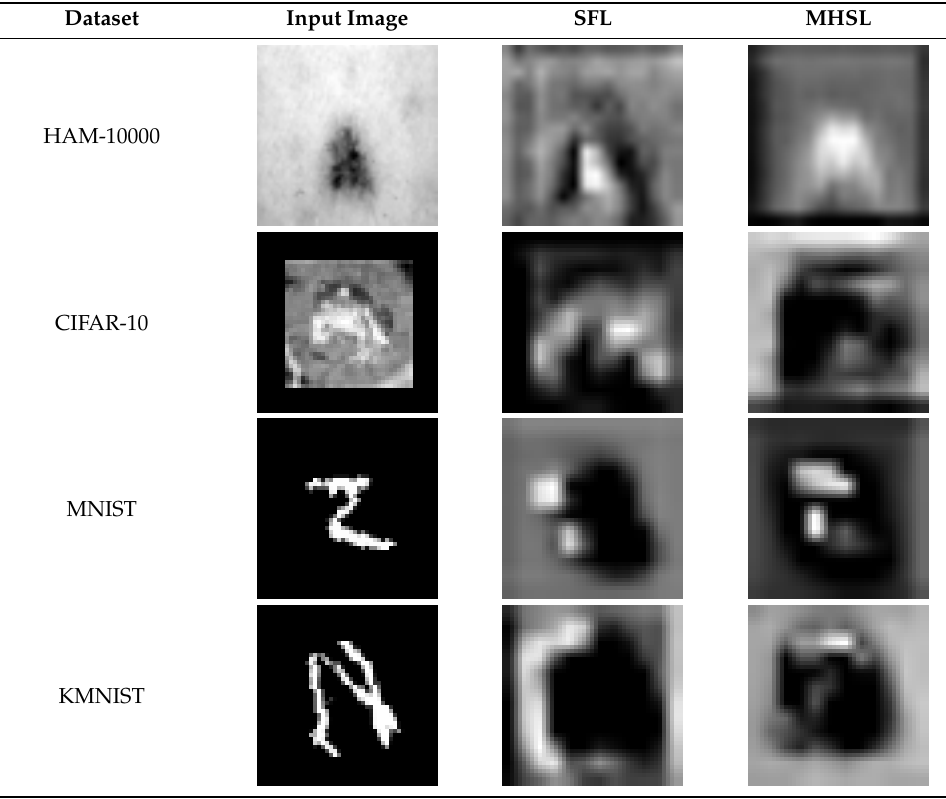
Table 7. Visual comparison of input images against SFL and MHSL at cut-layer three during an evaluation